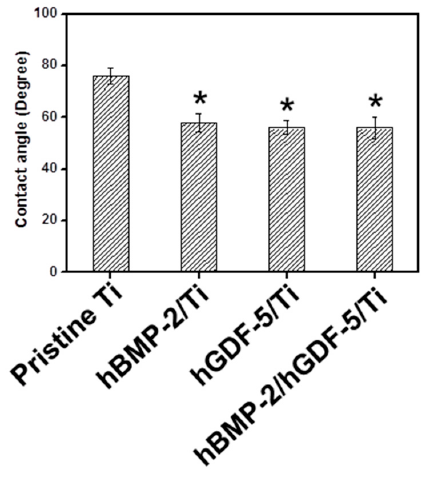
Figure 3. Water contact angles on pristine Ti; hBMP-2/Ti; hGDF-5/Ti, and hBMP-2/hGDF-5/Ti samples. The error bars represent mean ± SD ( n = 3). This experiment was repeated three times (* p < 0.05).